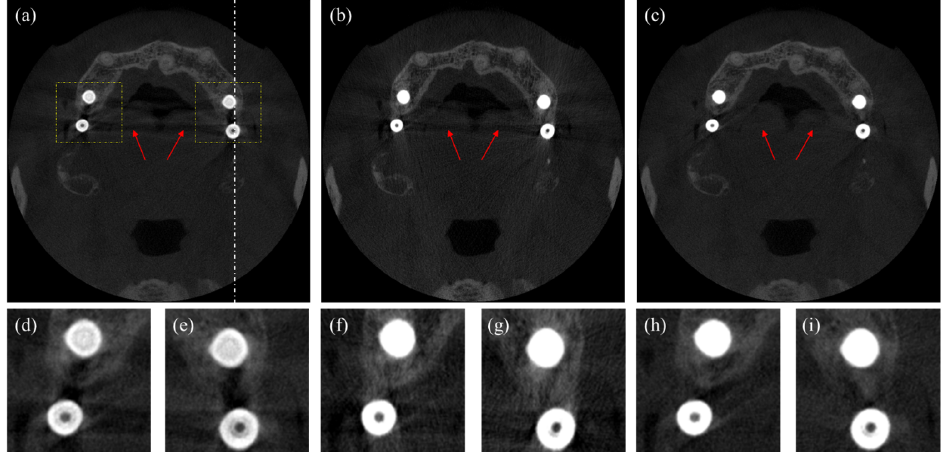
Figure 10. Axial images of a patient having four dental implants. ( a ) The uncorrected CT image, ( b ) the CT image corrected by the DSC method, and ( c ) the CT image corrected by the proposed method. The magnified images of the ROIs in ( d , e ) Figure 10a, ( f , g ) Figure 10b, and ( h , i ) Figure 10c. (Contrast window is [ − 1117~8564] in Hounsfield Unit).